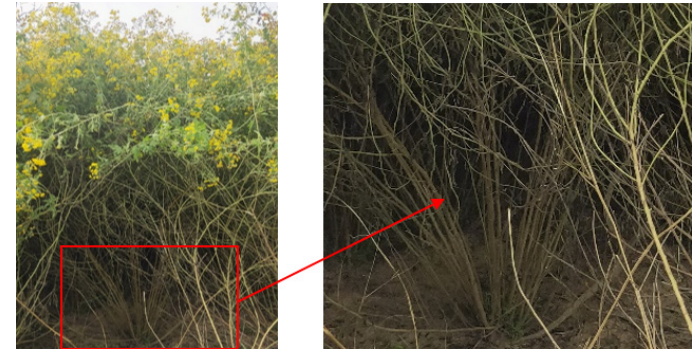
Figure 1. Stem image of a wild chrysanthemum.